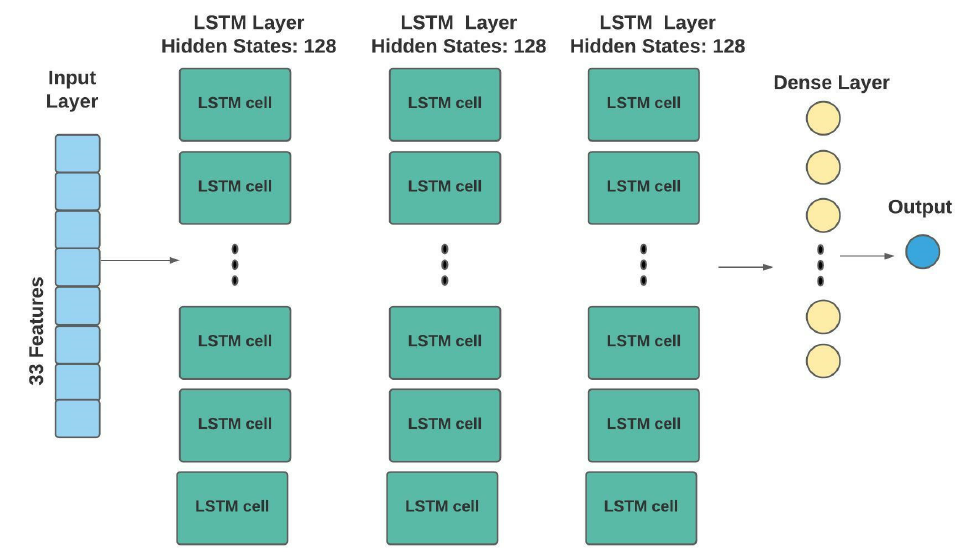
Figure 17. LSTM forecasting model.